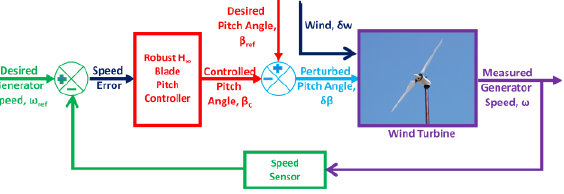
Figure 1. Block diagram of the wind turbine with control feedback